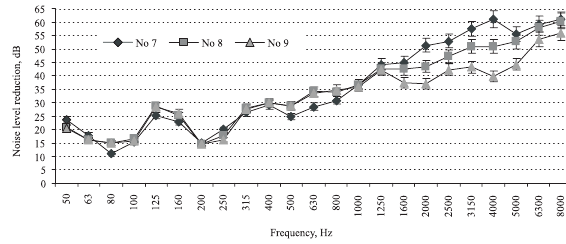
Fig. 4. Results of noise level reduction of samples of experimental structures No 7, No 8 and No 9 (Table 1)